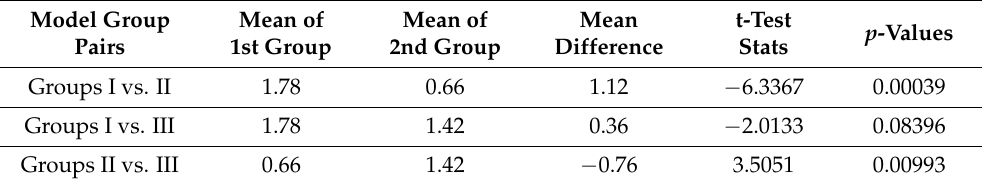
Table 10. Results of pairwise t-test of the group mean.